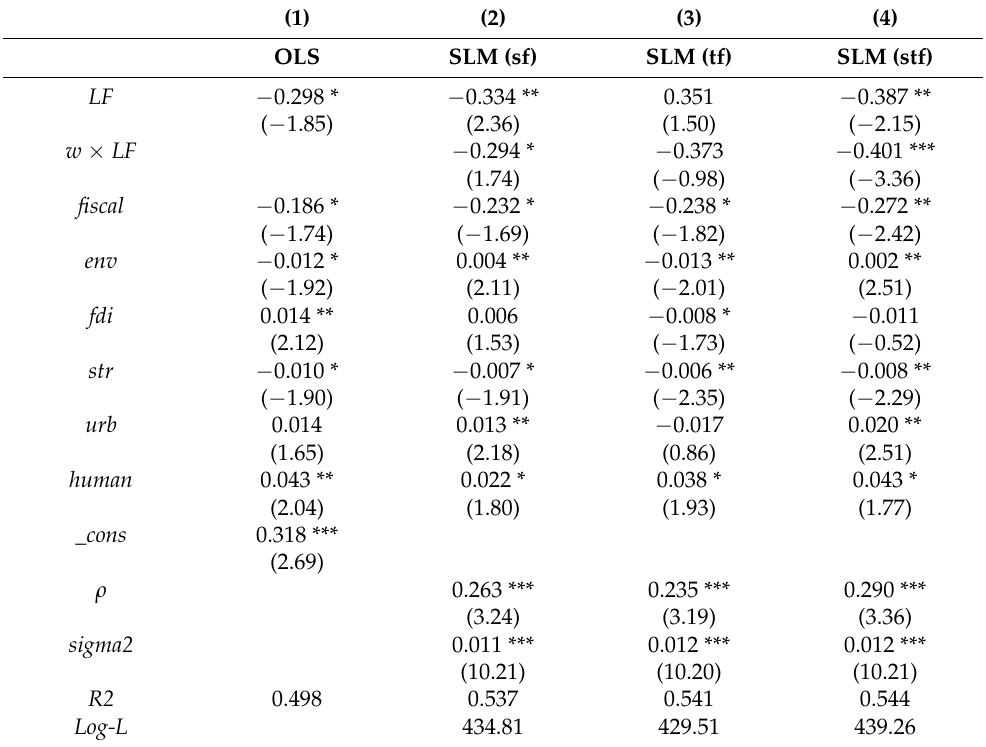
Table 5. Analysis of regression results.